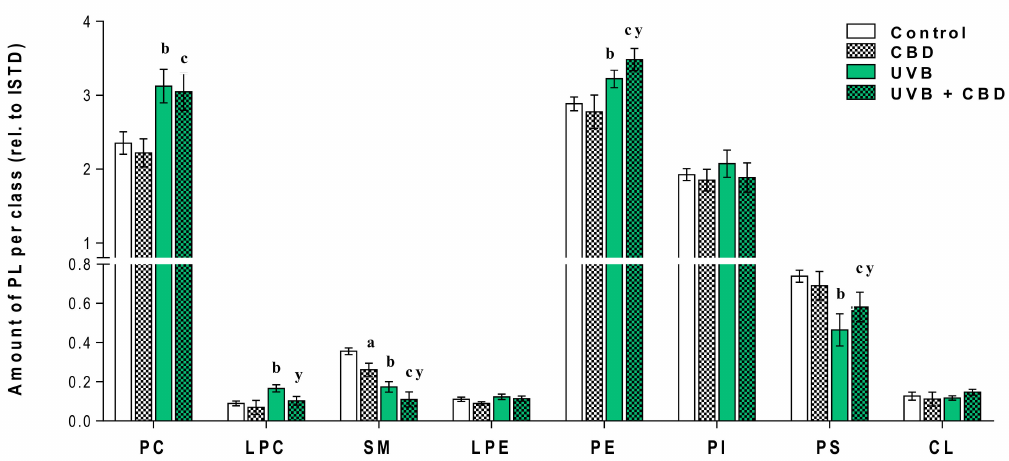
Figure 4. Changes in relative phospholipid content related to the internal standard of each phospholipid class within each class in keratinocytes isolated from the skin of control (Control) and UVB-irradiated rats (increasing doses from 0.02 to 2 J / cm 2 for 4 weeks). These cells have not been treated (Control and UVB) or treated with CBD (CBD and UVB + CBD) (2.5 g CBD in 100 g petrolatum); values are mean ± SD, p < 0.05; (a), CBD vs. control; (b), UVB vs. control; (c), UVB + CBD vs. control; (y), UVB + CBD vs.